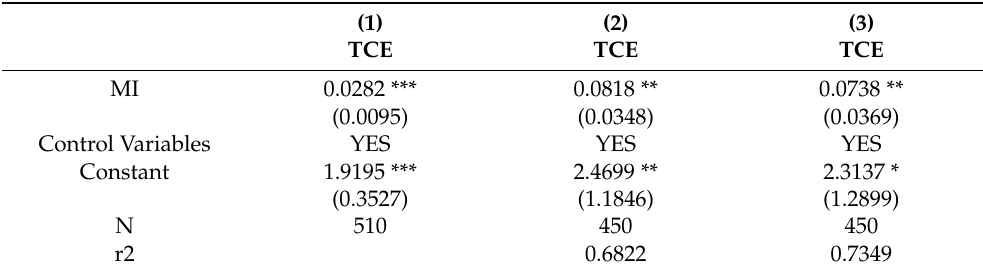
Table 4. Robustness test